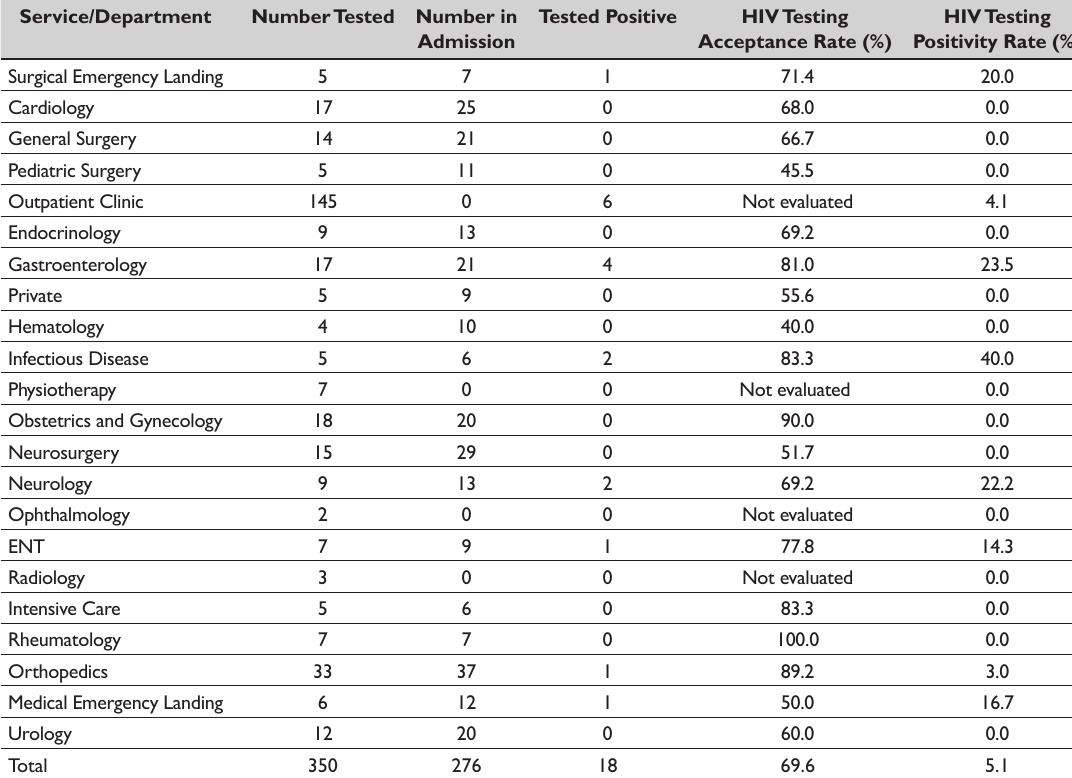
Table 3: HIV Case Identification by hospital unit